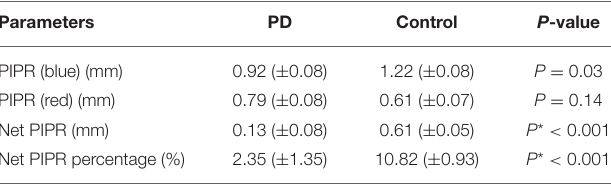
TABLE 2 | Pupillary response parameters and significance testing to discriminate between PD and Control subjects. Parameters PD